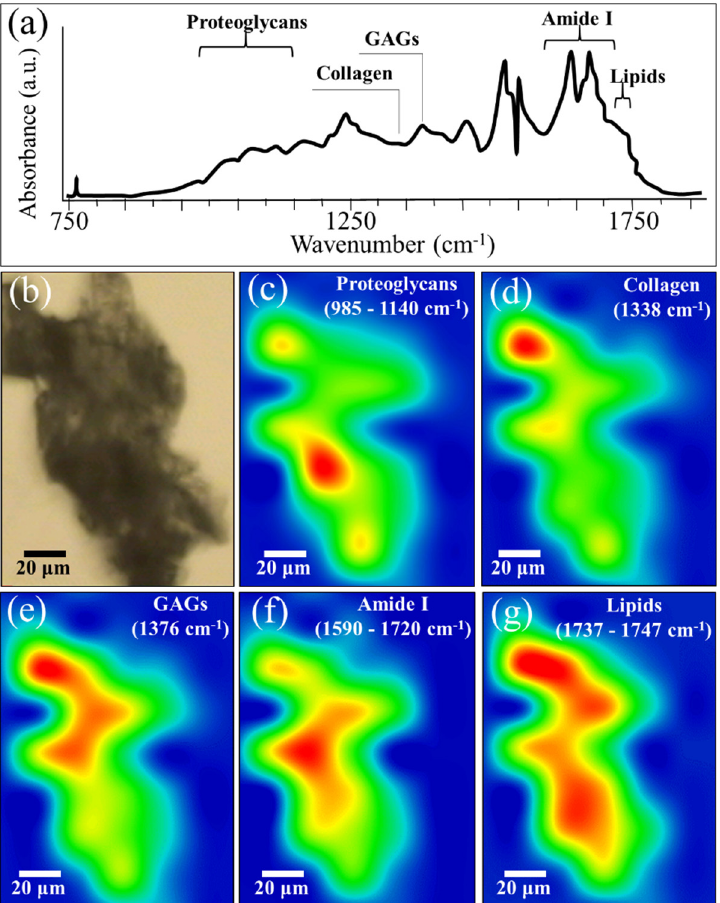
Figure 9. The spectrum in ( a ) shows the average SR-FTIR spectrum obtained on the cross-section of the cartilage sample grown onto the NanoCliP-FD gel scaffold given in the bright-field optical micrograph ( b ). In ( c – g ), related SR-FTIR images are given for proteoglycan, collagen, GAGs, amide I, and lipids, respectively (cf. mapping wavenumbers in inset to each figure).